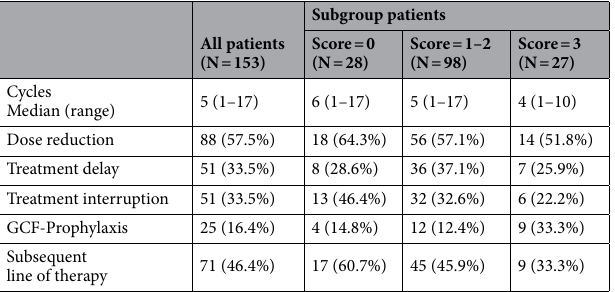
Table 2. Dose reduction, treatment delay, treatment interruption and GCF- prophylaxis according to score population. Number (N); granulocyte-colony stimulating factor (GCF).